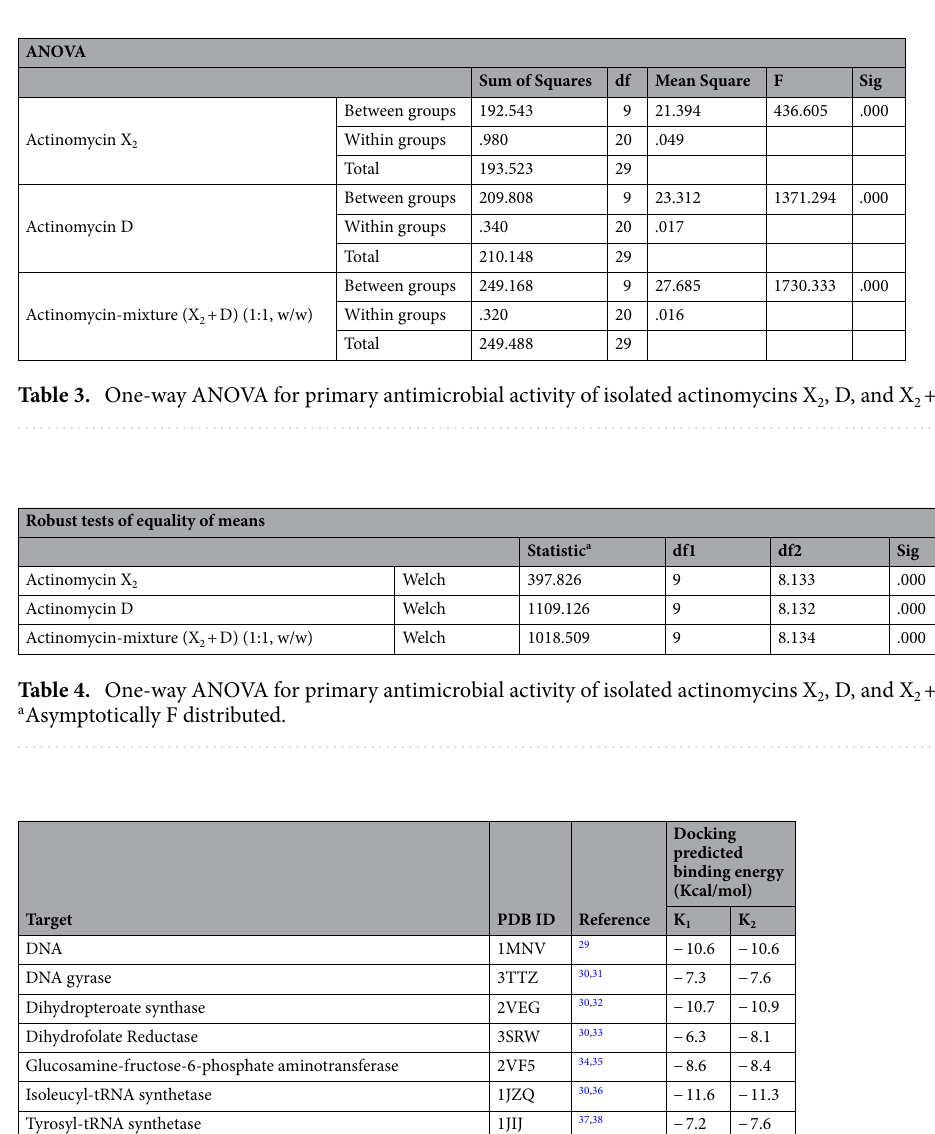
Isoleucyl-tRNA synthetase 1JZQ 30,36 Tyrosyl-tRNA synthetase